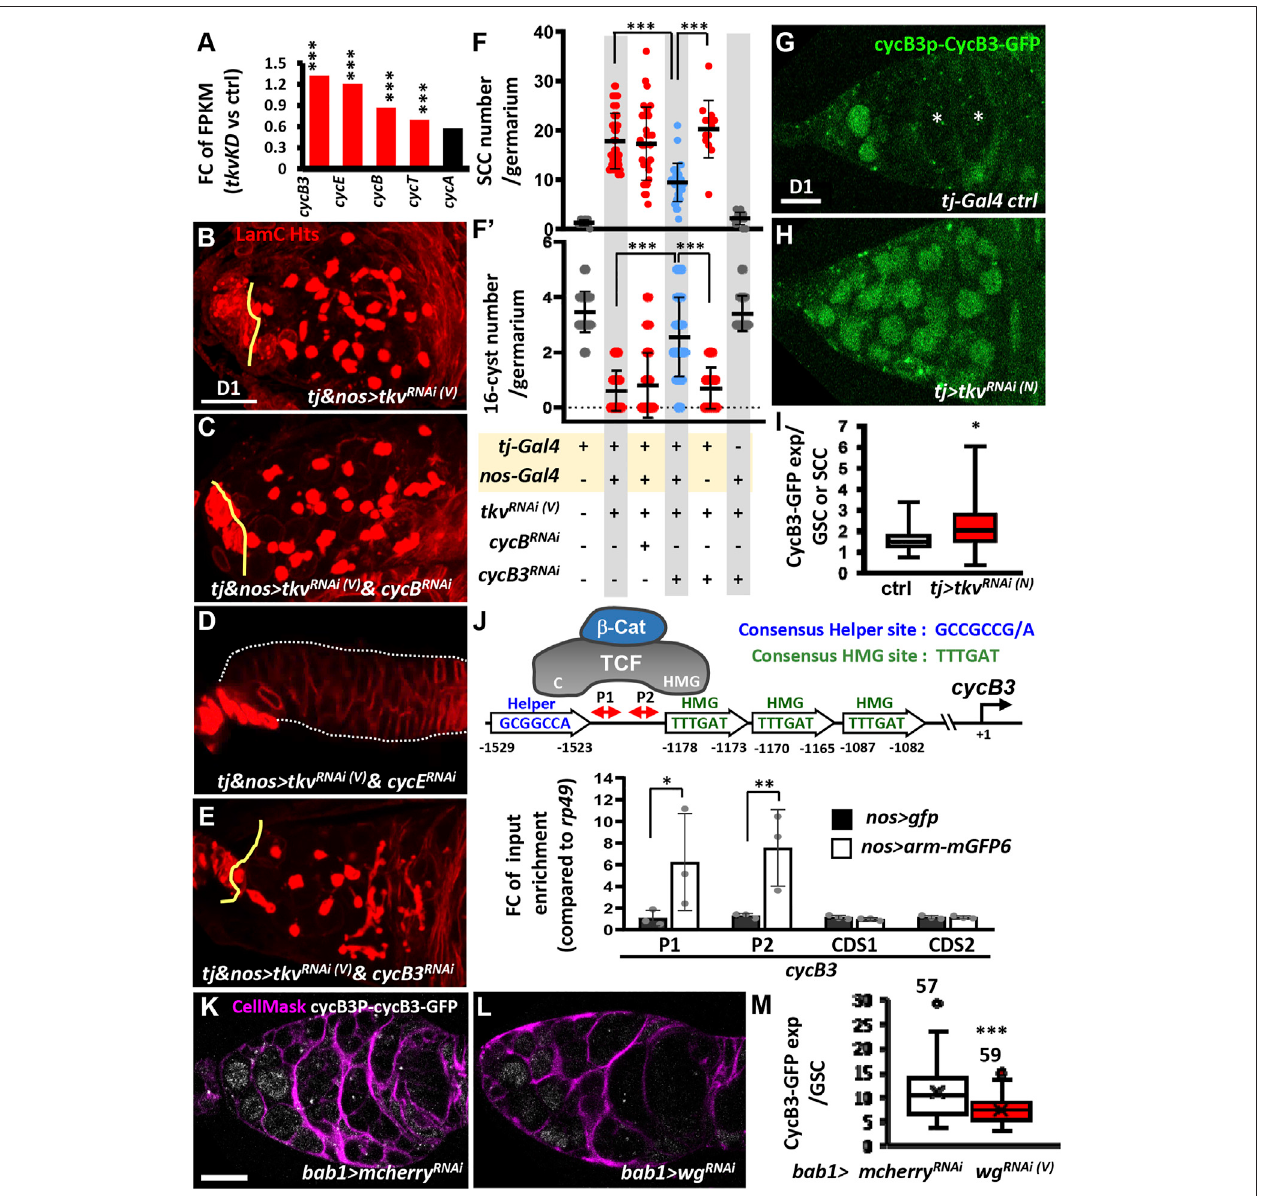
FIGURE 5 | Canonical Wnt signaling transcriptionally activates cycB3 tosuppressdifferentiation inthe germline ofsomatic-tkv knockdown germaria. (A) Fold-change (FC) of RNA -seq-based gene expression values (log2) for indicated cyclin (cyc) gene in 1-day (D) -old control (ctrl, UAS-tkv RNAi(N) /+ ) and c587 > tkv RNAi(N) anterior ovarioles comparedwith UAS-tkv RNAi(N) /+ (control,ctrl).FPKM,fragmentsperkilobaseoftranscriptpermillionmappedreads.***, p < 0.001.Statisticalanalysiswasperformedwithtwo biological replicates. (B to E) One-day-old tj & nos > tkv RNAi (V) () (B) , tj & nos > tkv RNAi(V) & cycB RNAi (C) , tj & nos > tkv RNAi(V) & cycE RNAi (D) and tj & nos > tkv RNAi (V) & cycB3 RNAi (E) and with LamC (red, terminal fi lament and cap cellnuclear envelopes) and Hts (red, fusomes). Solid lines mark junction between GSCsand cap cells; dashed linesoutline the germariainD. (Fand F ’ ) Numbers ofspectrosome-containing cells (SCCs) (F),and 16-cellcysts pergermarium (F ’ ) of fl ies withthe indicated genotypes. (G andH) Liveimageof1-day-old tj > GFP RNA(III) (G) and tj > tkv RNAi(V) germaria (H) bearing cycB3P-cycB3-gfp (Green,CycB3-GFP). (I) BoxplotshowsexpressionofCycB3- GFP in GSCs or SCCs in the indicated genotypes. (J) Schematic shows how β -catenin ( β -Cat) interacts with TCF, which binds to HMG and Helper sites of the cycB3 promoter through its HMG and C domains, respectively. ChIP analysis of TCF binding in 1-day-old ovaries; the chromatin from nos > gfp and nos > arm-mgfp6 cells was precipitatedwithGFP-Trapbeads.Co-precipitatedDNAwasanalyzedbyqPCRusingtwosetsofprimers(P1andP2)againsttheregionbetweenHelperandHMGsites.The amplicons oftwo different coding regions were used as negative controls. (K and L) One-day-old bab1 > mcherry RNAi (K) and bab1 > wg RNAi (V) (L) with cycB3P-CycB3-GFP (gray)andCellMask(Magenta,cellmembrane). (M) AverageofCycB3-GFPexpressioninGSCsofindicatedgenotypes.NumberofGSCsanalyzedisshownaboveeachbar. DifferencesinFandF ′ wereanalyzedbyone-wayANOVA;datainIandMwereanalyzedbyStudent ’ s t test,andinJwereanalyzedbytwo-wayANOVA.Solidlineinthebox ofIandMismedian;crossinMisMean.ErrorbarsrepresentSD;*, p < 0.05;**, p < 0.01;***, p < 0.001. RNAi wasexpressedthroughoutdevelopmentuntildissection.Scale bar is 10 μ